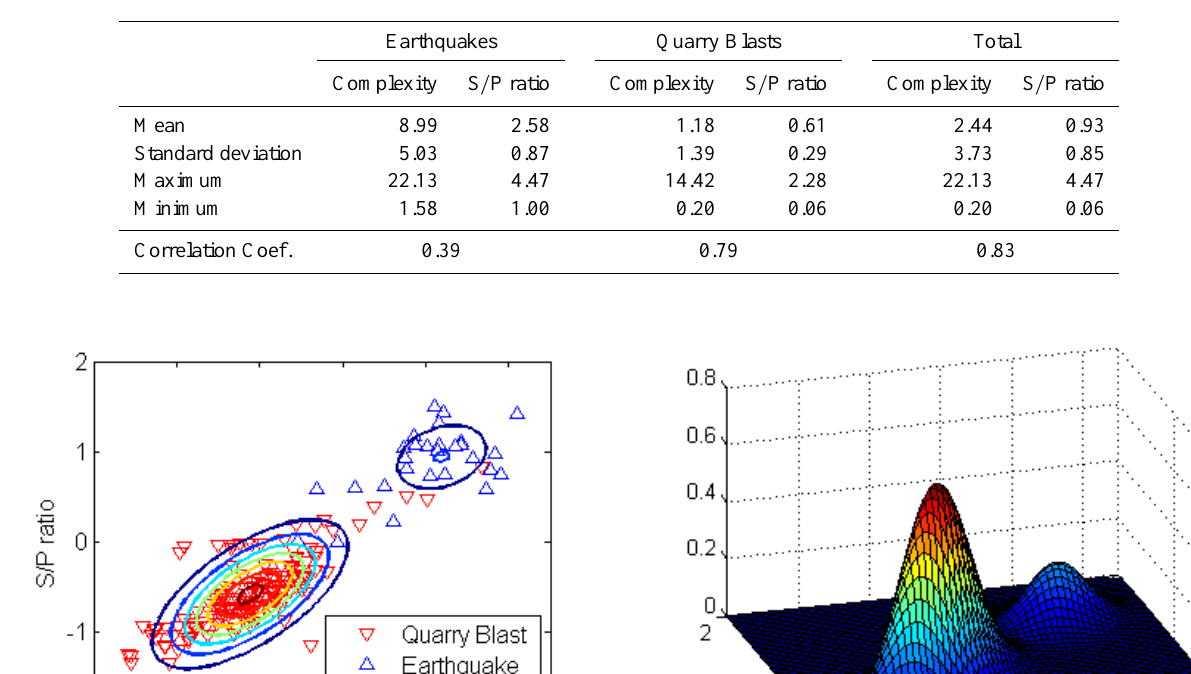
Table 1. Fundamental descriptive statistical information about the data and their ranges.